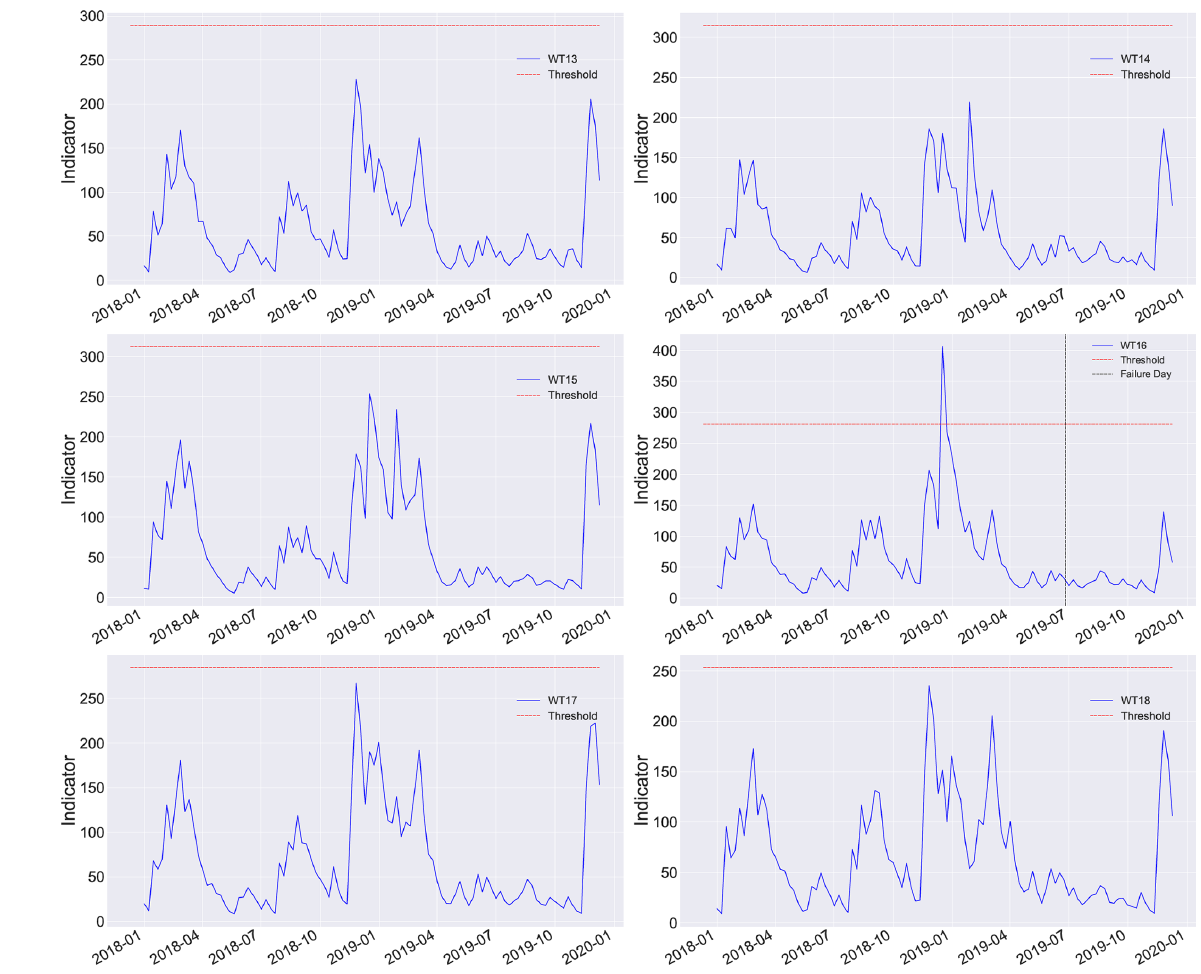
Figure 12. Weekly indicator